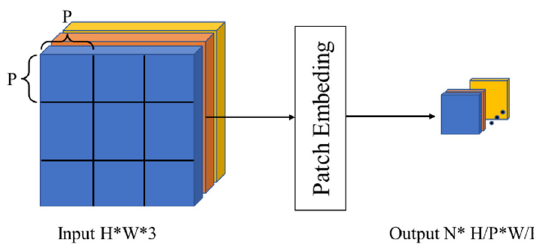
Figure 5. Patch embedding process.